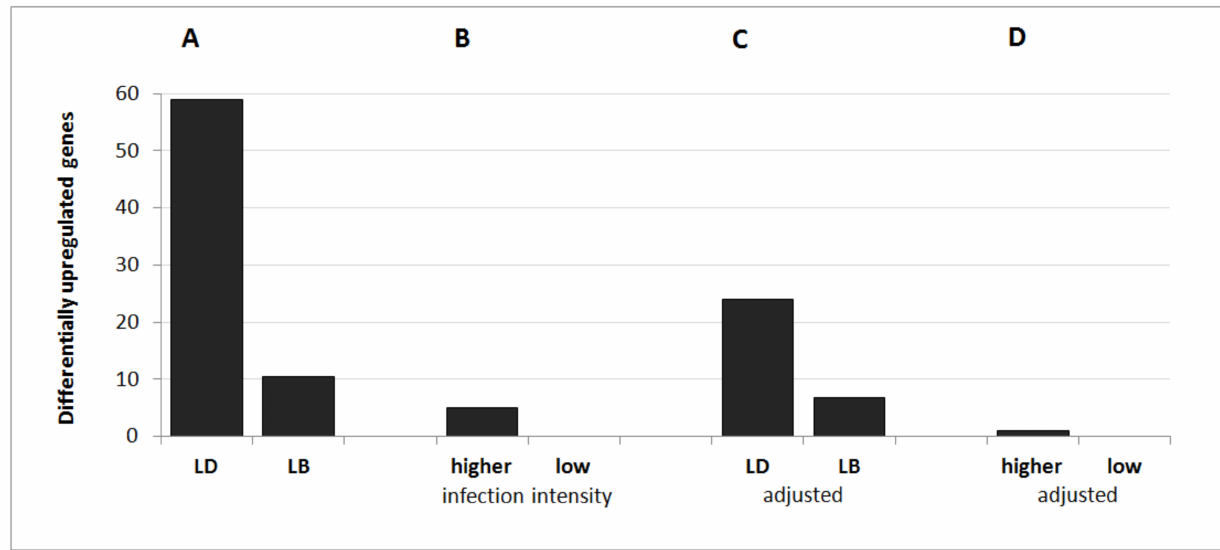
Figure 2. Number of significantly upregulated genes ( A ) between Lohmann Dual (LD) and Lohmann Brown Plus (LB) hens, ( B ) between hens with lower and higher infection intensity levels, ( C ) between LD and LB genotypes adjusted for infection intensity, and ( D ) between lower and higher infection intensity levels adjusted for genotype